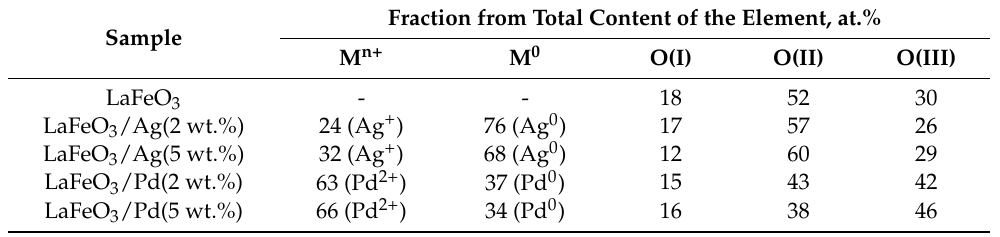
Figure 3. XP spectra of pristine and Ag- or Pd-modified LaFeO 3 in the analytical regions of La 3d ( a ), Fe 2p ( b ), Ag 3d ( c ), Pd 3d ( d ) and O 1s ( e ). Fe 2p ( b ), Ag 3d ( c ), Pd 3d ( d ) and O 1s ( e ). Table 2. Relative fractions of oxidized (M n+ ) and reduced (M 0 ) states of noble metals in Ag- and Pd-modified LaFeO 3 and of different states of oxygen in the materials determined by